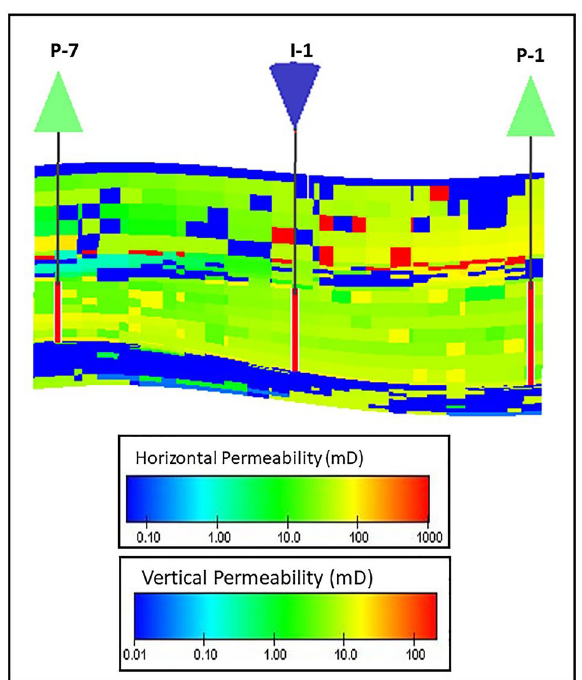
Fig. 10 Distribution of the horizontal and vertical permeability for a plane intercepted by the wells P-7, I-1 and P-1 which is a characteristic of the miscible method. Clark et al. (1958) have reported similar behavior.